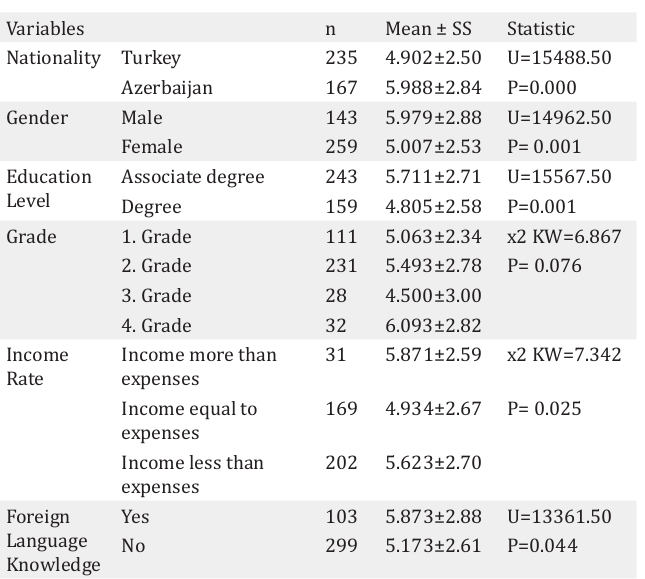
Comparison of Students' Demographic Characteristics and Narcissism Personality Inventory